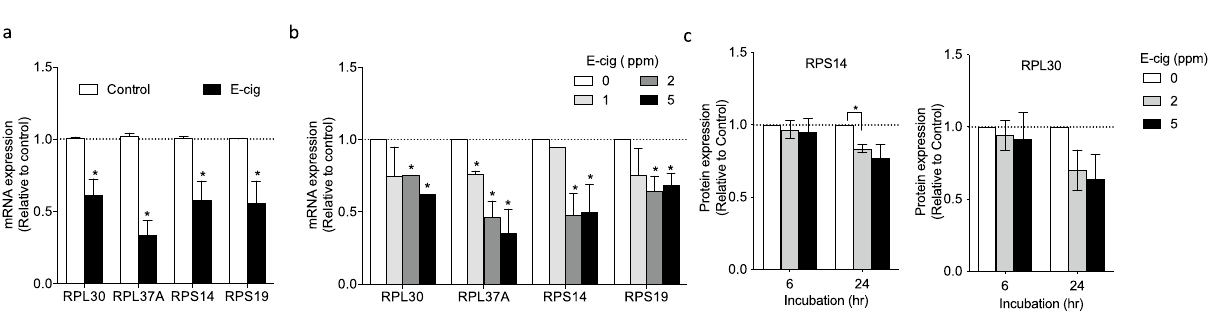
Figure 2. Effect of e-cig smoke solution on expression of ribosomal proteins in NHBE cells ( A ) Expression of ribosomal protein-encoding genes measured by qPCR. ( B ) Expression of ribosomal protein-encoding genes in NHBE cells at varying concentrations of e-cig solution measured by qRT-PCR. ( C ) Protein quantification of ribosomal proteins measured by Western blot. *p < 0.05 significant compared to control, N = 3